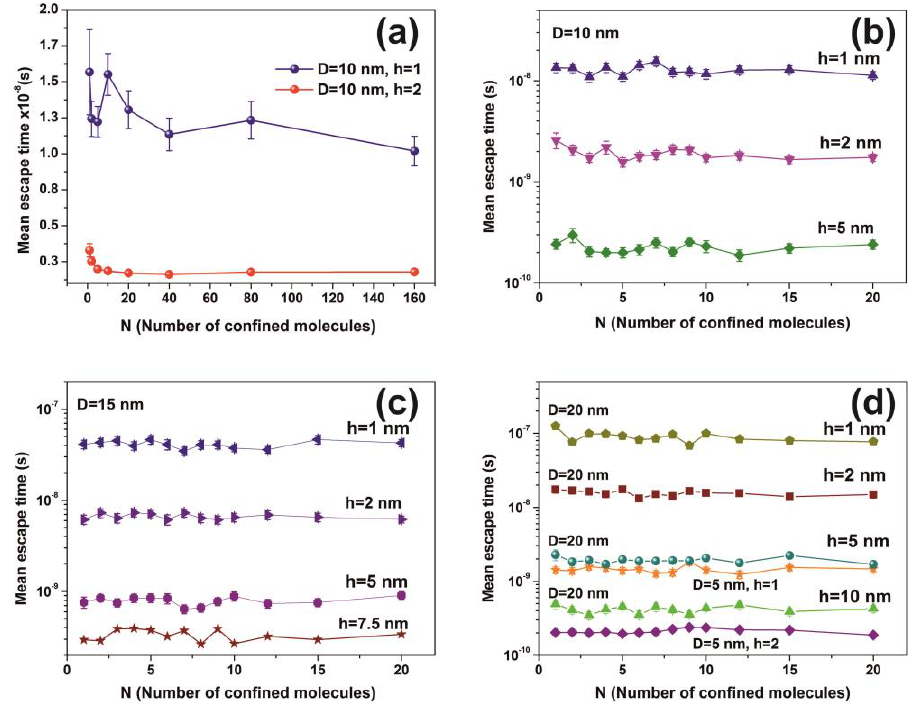
Figure 12. Mean escape time for a di ff erent number of non-interactive molecules calculated for 10 3 runs. ( a ) Fluctuations of mean molecular escape time are prominent for small size cavities, while remains constant for a large number of molecules; ( b – d ) mean escape time for 5, 10, 15 and 20 nm spherical cavities with di ff erent entrance-escape holes and number of molecules in the cavity. The mean escape time is independent of the number of molecules and is a function only of the cavity geometry (diameter and entrance-escape hole).